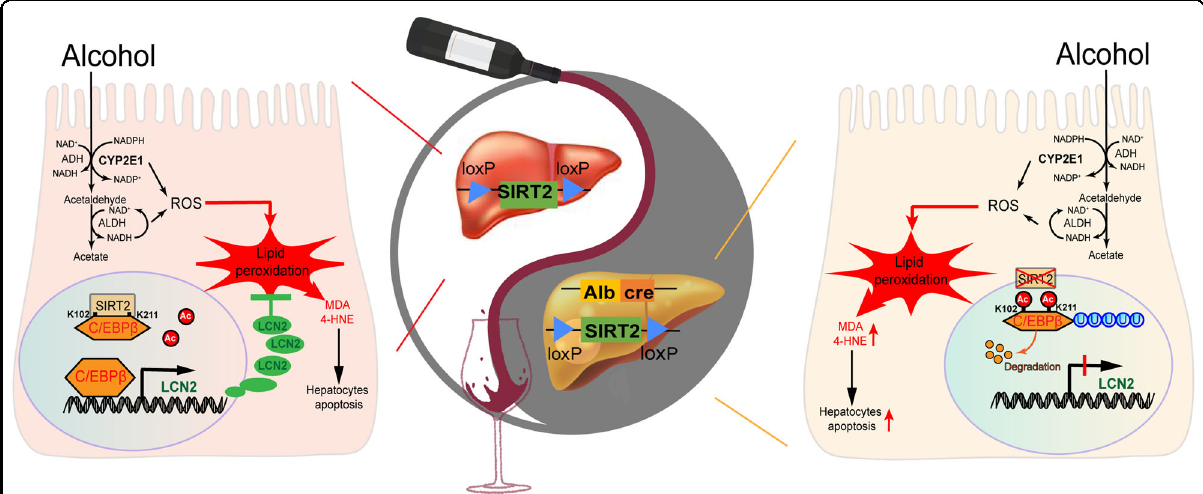
Fig. 9 Model. Protective mechanism of hepatic SIRT2-C/EBP β -LCN2 axis in ALD. Ethanol upregulated SIRT2 in hepatocytes, which directly deacetylates C/EBP β on lysines 102 and 211 and inhibits ubiquitination of C/EBP β , and subsequently promotes the transcription of LCN2. This in turn prevents oxidative stress and lipid peroxidation induced by ethanol. SIRT2 KO increases ubiquitination and degradation of C/EBP β and aggravates ethanol-induced liver